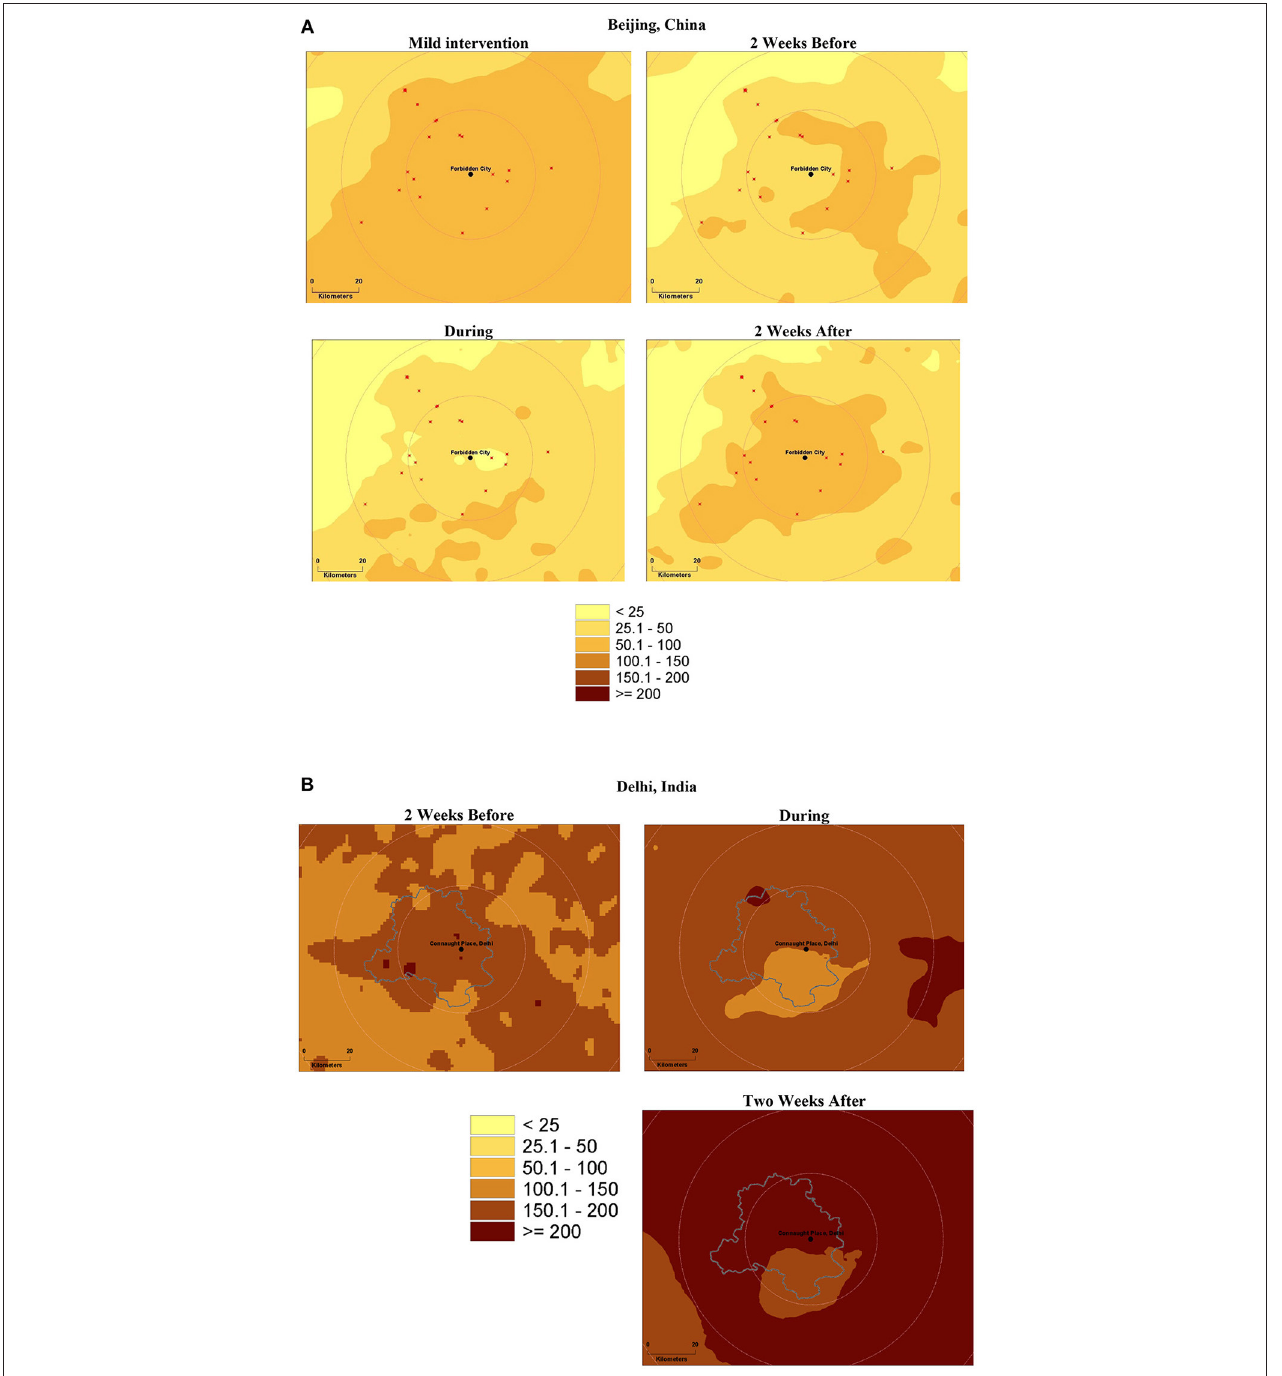
FIGURE 4 | PM 2.5 ( µ g/m 3 ) distribution 2 weeks before, during and two after the even-odd traffic rationing programs and Delhi, India (A) Beijing, China (B)